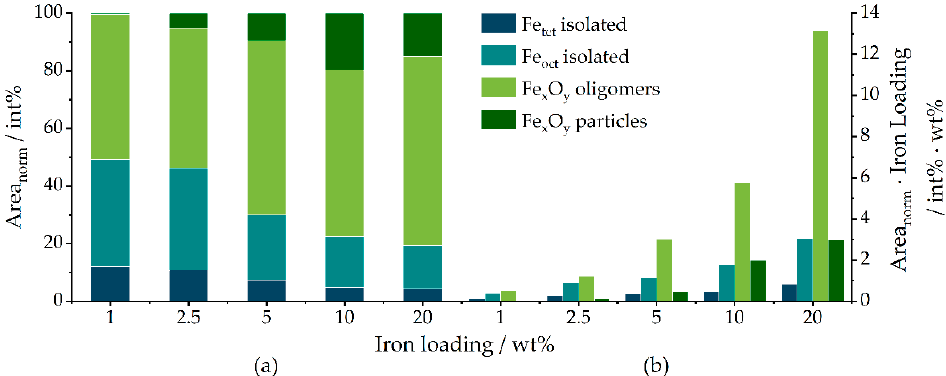
Figure 8. ( a ) Normalized areas obtained from peak deconvolution of the DRUV spectra of Fe01 to Fe20; ( b ) total amounts of the species respective to the overall catalyst mass, calculated by multiplication of the integrated percentual areas with the iron loading. Table 4. Parameters obtained from peak deconvolution area of the DRUV spectra of Fe01 to Fe20.